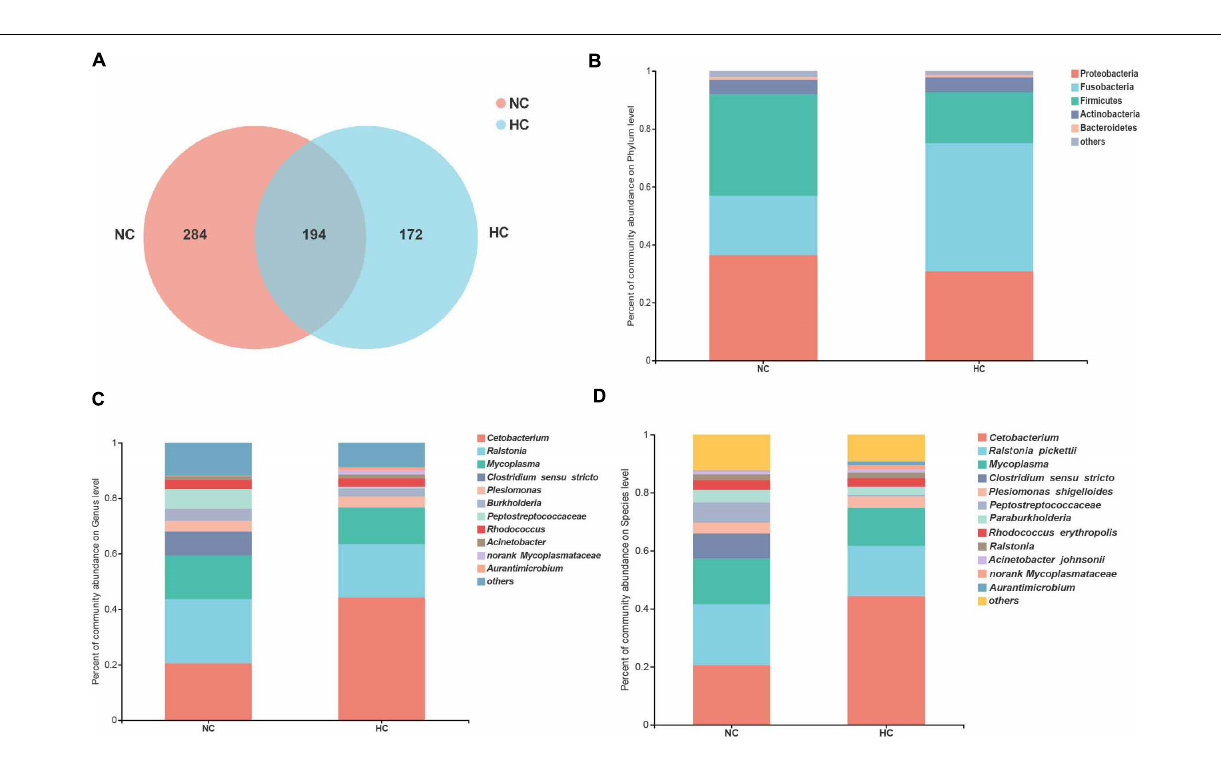
Frontiers in Microbiology |